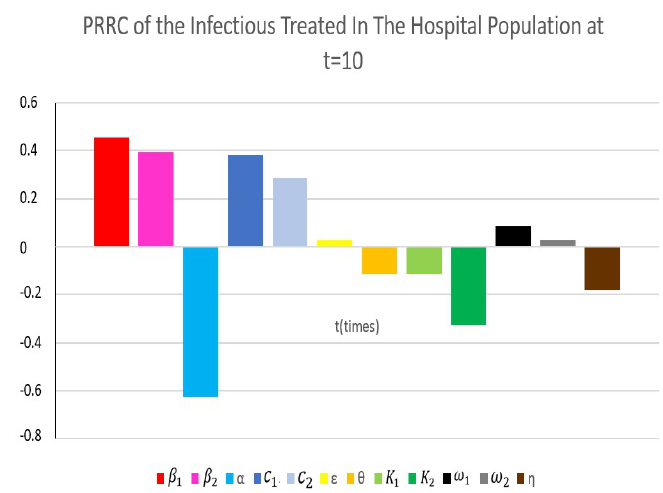
Figure 10. The bar chart for PRCC of the infectious population treated in the hospital at t = 10.